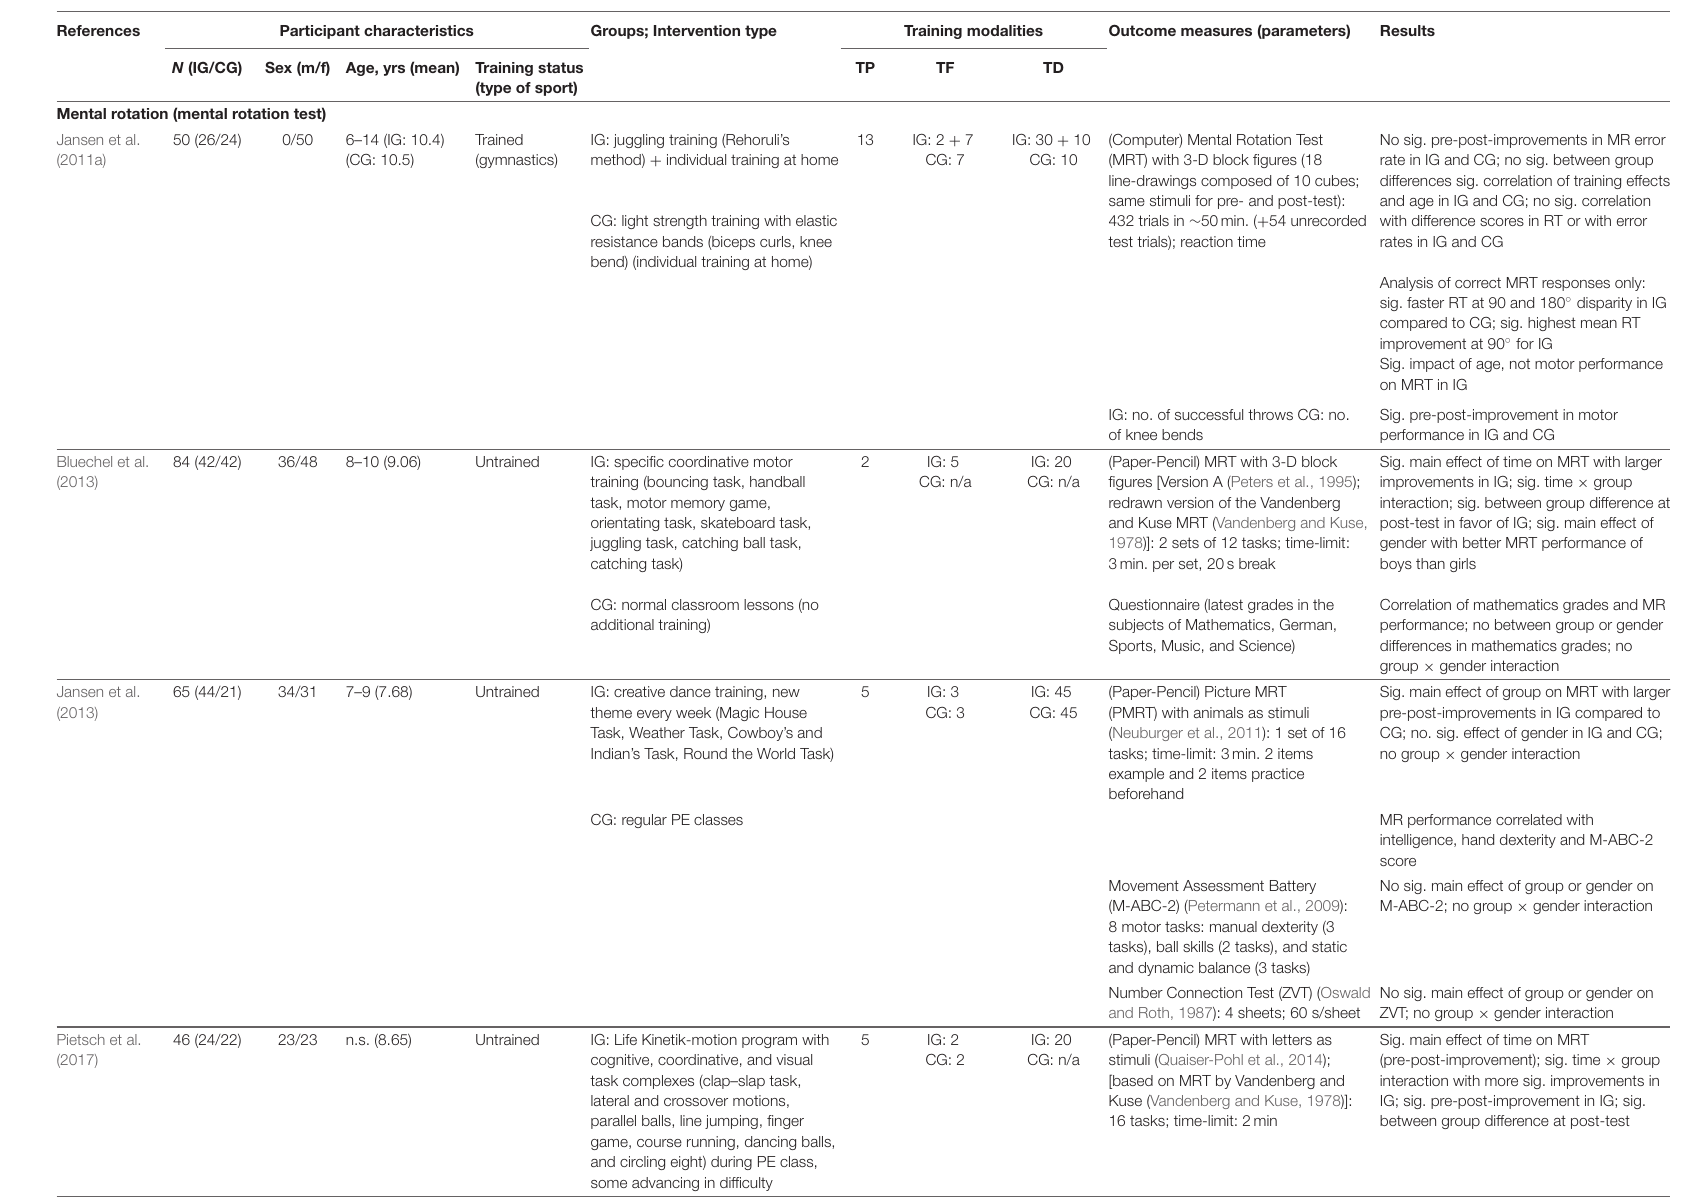
TABLE 1 | Overview of included studies.